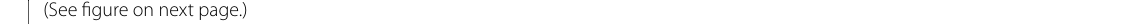
Fig. 3 SE upregulates FKN/CX3CR1 in the sp5c of migraine model rats. A Representative western blot images showing CX3CR1 and FKN protein expression in the cortex/thalamus/sp5c of SE model rats. B‑C Western blot analysis showing that CX3CR1 and FKN protein levels of in the cortex/ thalamus/sp5c were upregulated in the SE group compared to the sham group. Mean SEM; unpaired t test versus sham group; n 3 rats per ± = group; * P < 0.05, ** P < 0.01. D Representative western blots showing CX3CR1 and FKN in the different groups. (E) Western blot analysis showing that the protein levels of CX3CR1/FKN were increased in the migraine group, and further increased in the comorbidity group. Mean SEM; ± one-way ANOVA; n 4 rats per group; * P < 0.05, ** P < 0.01, *** P < 0.001. F Representative immunofluorescence images showing CX3CR1 cells = + (green) colocalized with Iba1 cells (red) in the sp5c of different groups. Scale bars 50 μm. The white box was enlarged. G Representative + = immunofluorescence images showing FKN cells (green) colocalized with Neun cells (red) in the sp5c in the different groups. Scale bars 50 μm. + + = H‑I Quantification of CX3CR1 and iba1 immunoreactivity (in arbitrary units) in the sp5c. Mean SEM; one-way ANOVA; n 3 rats per group; ± = ** P < 0.01, *** P < 0.001. J Quantification of FKN immunoreactivity (in arbitrary units) in the sp5c. Mean SEM; one-way ANOVA; n 3 rats per group; ± = ** P < 0.01, *** P